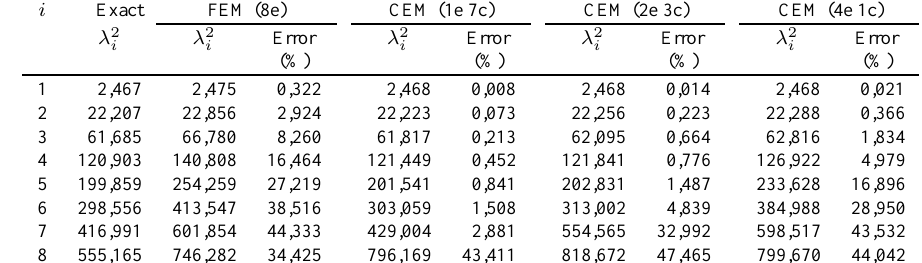
Fig. 9. Plane truss. Table 1 Results from the FEM and CEM with 8 degrees of